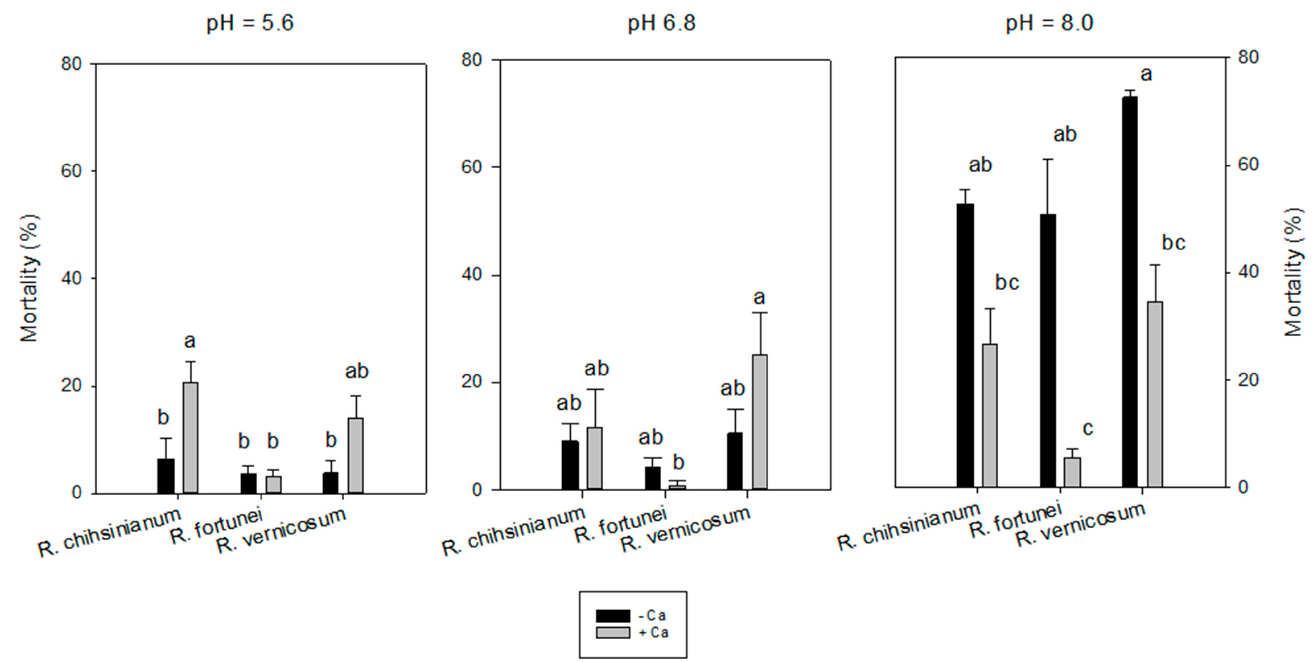
Figure 5. Mortality of three Rhododendron sp. at different pH and with/without additional calcium. Mean ± SE, n = 5—a,b indicate significant differences according to Tukey’s HSD test for each pH level.